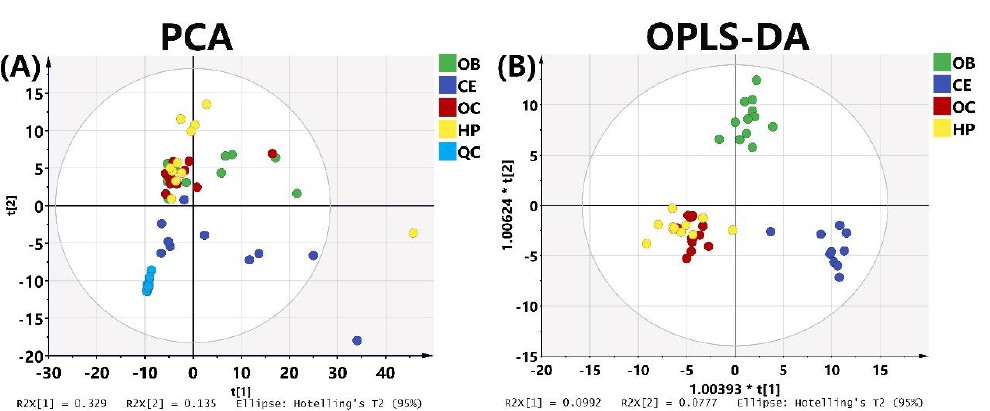
Figure 5. ( A ) Principal component analysis (PCA0 score plot of 4 brain regions (R 2 X = 0.749, Q 2 = 0.541). ( B ) Orthogonal partial least squares–discriminant analysis OPLS-DA score plot of 4 brain regions (R 2 X = 0.698, R 2 Y = 0.88, Q 2 = 0.71). Red dots represent OC; green dots represent OB; yellow dots represent HP; dark blue dots represent CE; light blue dots represent QC.